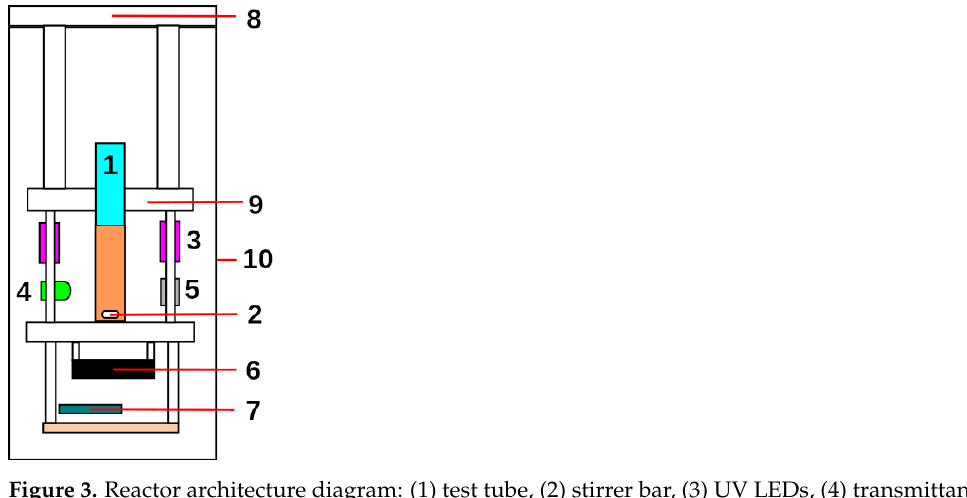
Figure 3. Reactor architecture diagram: (1) test tube, (2) stirrer bar, (3) UV LEDs, (4) transmittance LED, (5) sensor, (6) stirrer motor, (7) Arduino Nano Every, (8) top cover, (9) inner support and (10)